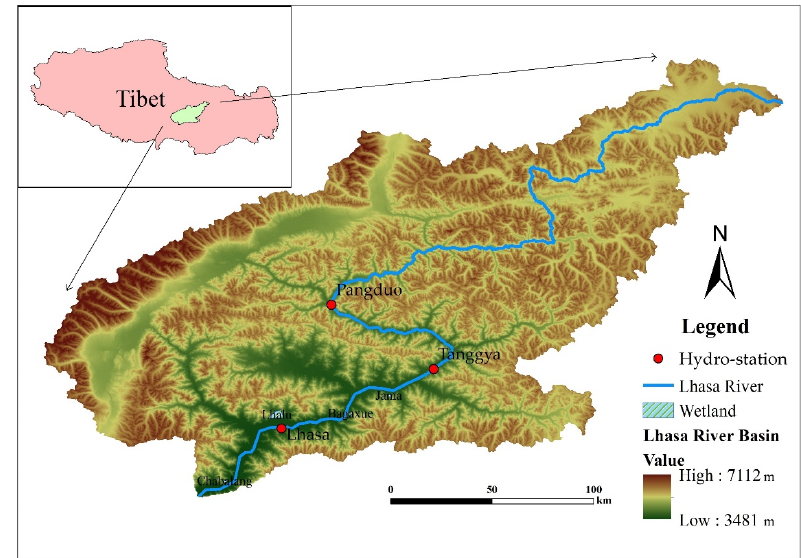
Figure 1. The location of the Lhasa River.